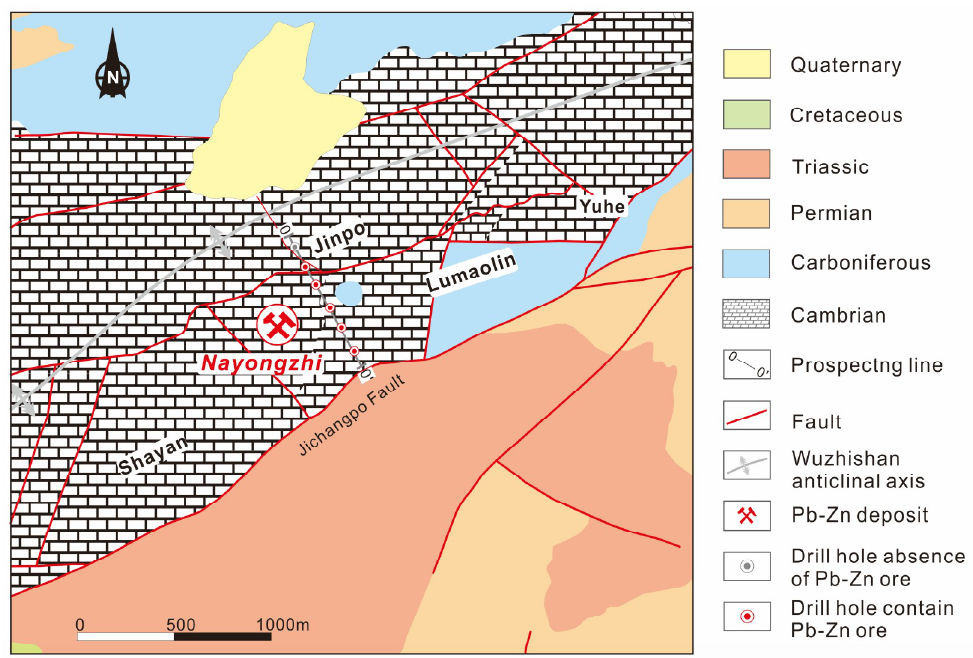
Figure 2. Geological sketch map of the Nayongzhi district (modified from Jin et al. [17]), showing the distribution of ore blocks, strata, faults.